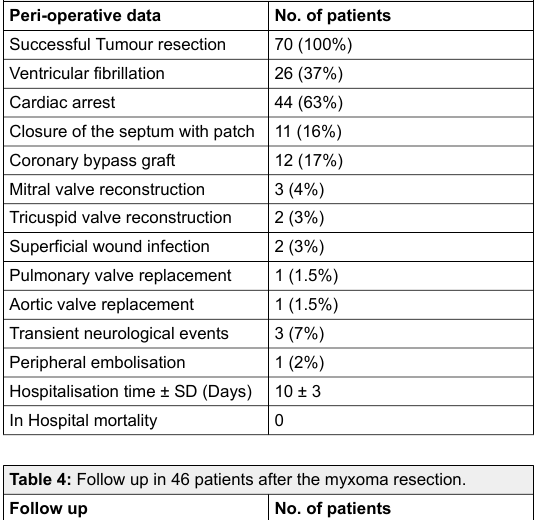
Table 3: Peri-operative evolution of the patients.